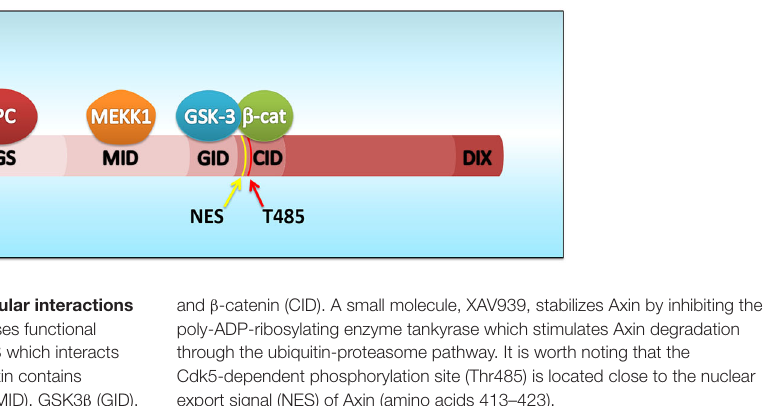
FIGURE 1 | Schematic diagram of Axin domains, molecular interactions and Cdk5-dependent phosphorylation site . Axin possesses functional domains including the Regulators of G protein signaling (RGS which interacts with adenomatosis polyposis coli, APC) and DIX domains. Axin contains domains for interacting with other proteins such as MEKK1 (MID), GSK3 β (GID),